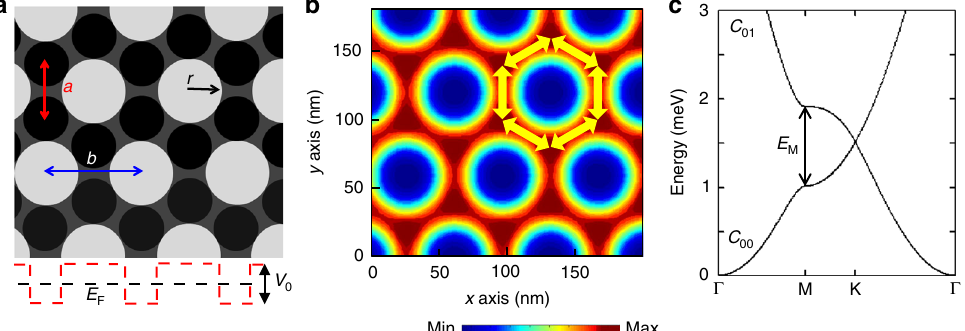
Fig. 1 Low-disorder arti fi cial graphene in triangular antidot lattices. a Schematic of a triangular antidot lattice with period b that is imprinted on a GaAs QW. The white circles represent etched antidots of radius r . The black and gray areas represent the unetched areas, and the black circles indicate the effective ffiffiffi p dots arranged in a honeycomb pattern of period a = b / 3 . In the evaluation of AG band structure, we used a muf fi n – tin potential (red dashed line) with Fermi energy E F in the single-particle approximation 9,10,14 . V 0 is the potential depth in the etched area. Each antidot produces an effectively repulsive potential V 0 . b Evaluations of electron density in a triangular antidot lattice with V 0 = 6 meV, b = 70 nm, a = 40.4 nm, and r = 20 nm. Yellow arrows highlight strengthened electron coupling between nearest-neighbor dots. The color bar indicates the electron density. c The two lowest Dirac bands of AG with the parameters in b . E M indicates the value of the gap near the